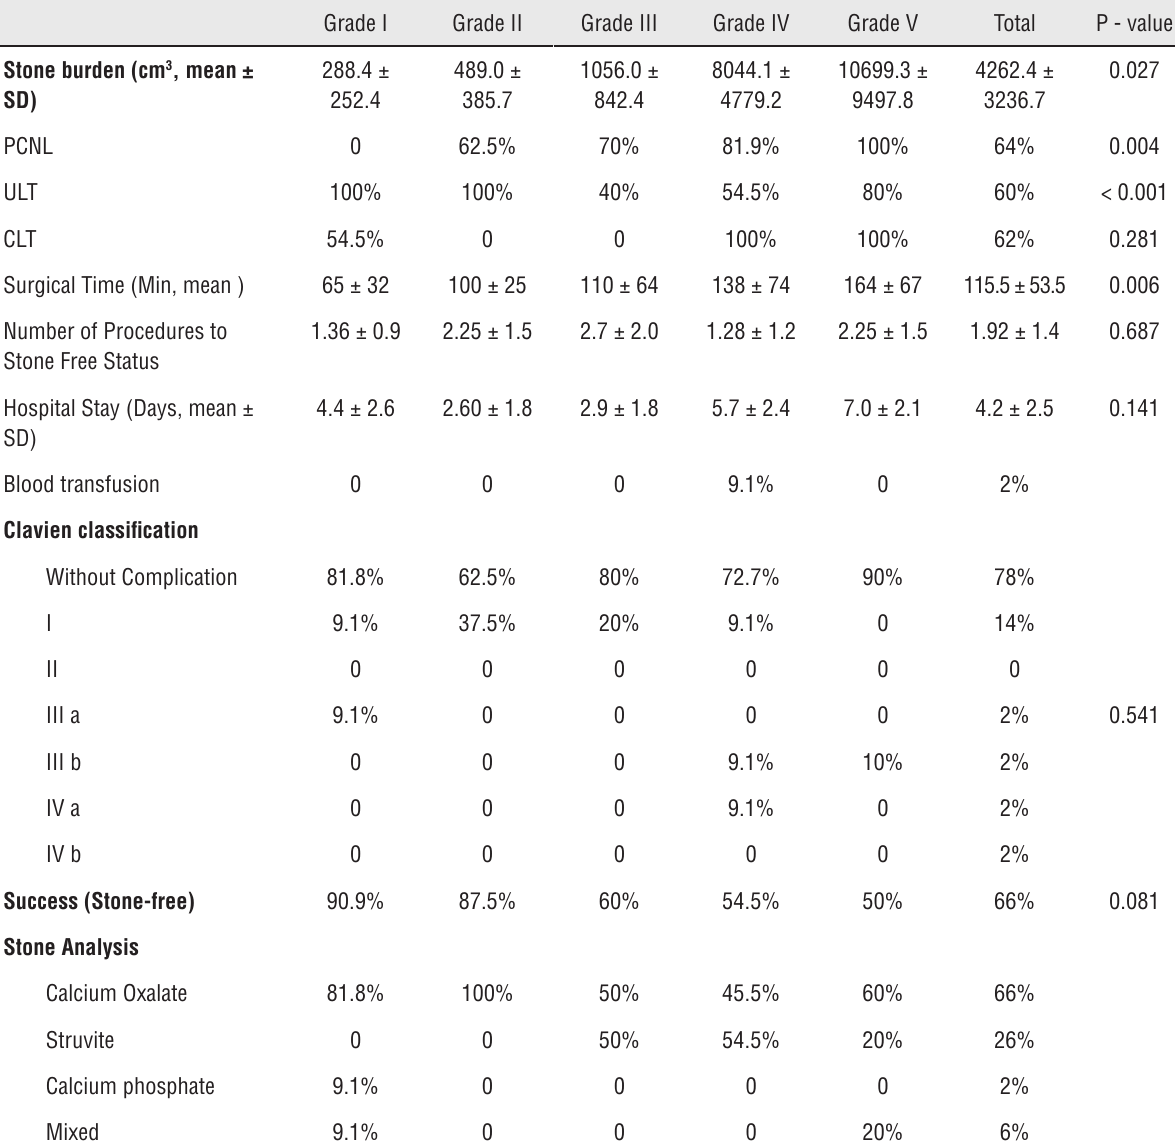
Table 2. Patients operative and peri-operative